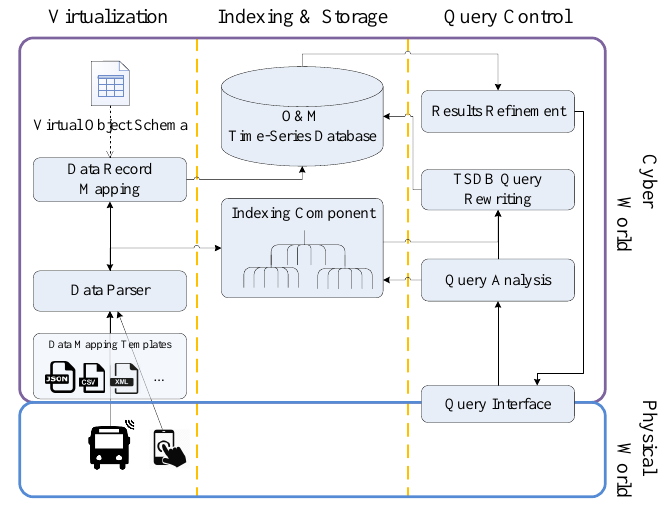
Figure 1. FUTS data retrieval framework.